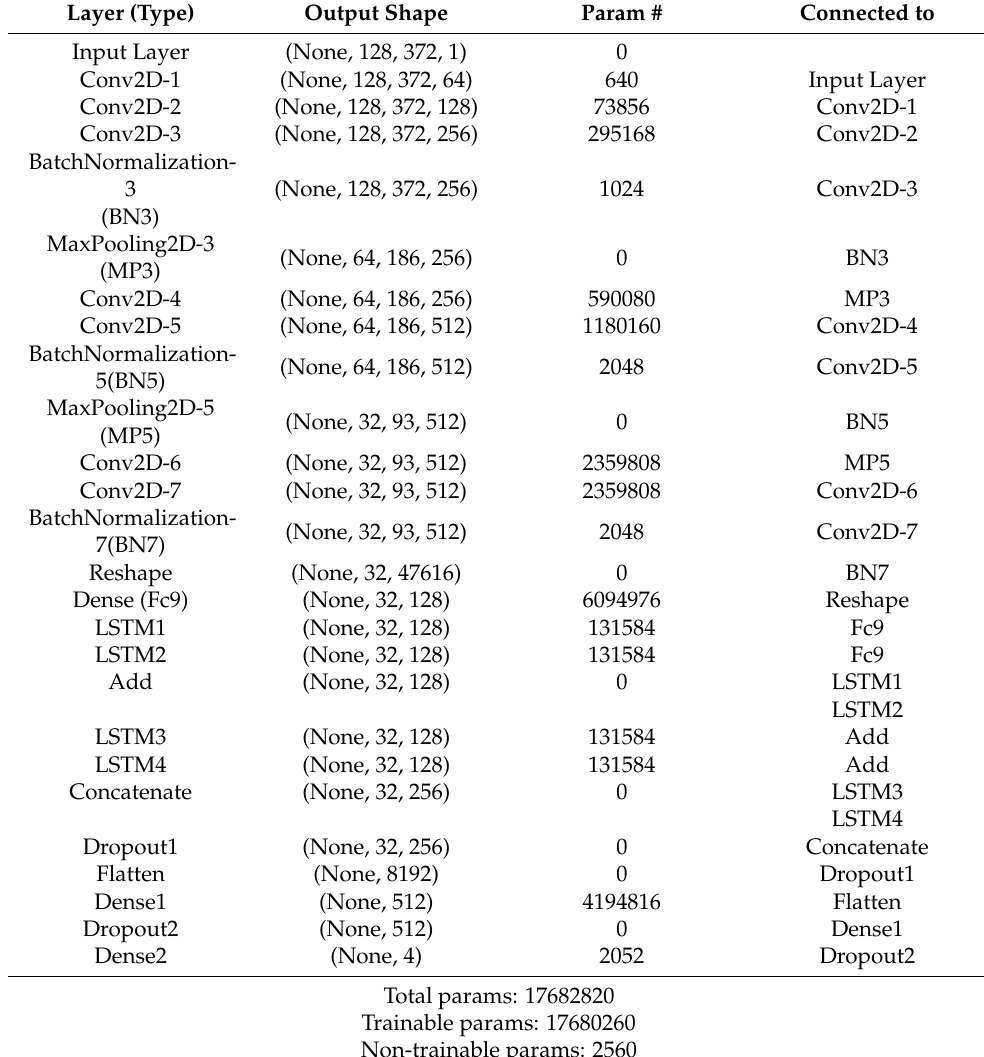
Table 4. Configuration of the CRNN model for 128